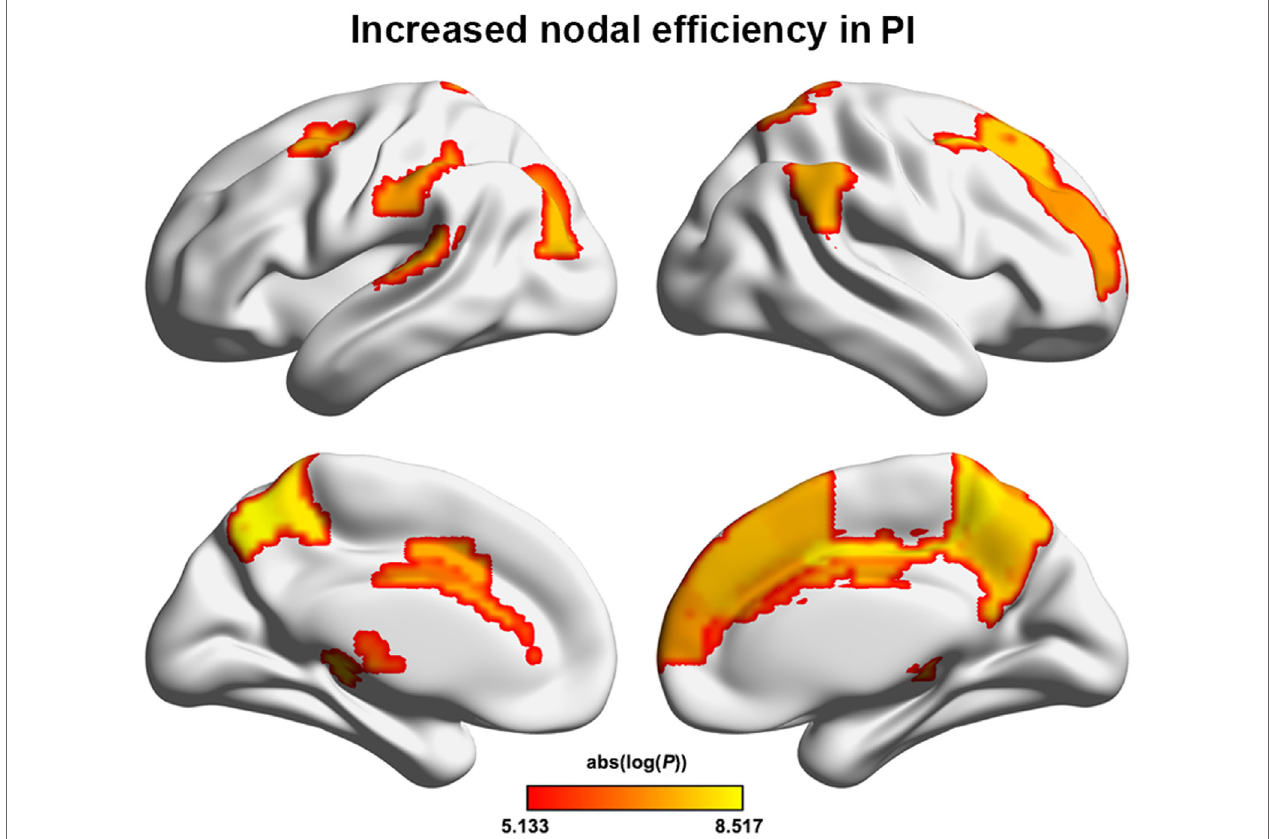
FigUre 2 | Between-group differences in regional nodal efficiency. Warm color regions show significantly increased nodal efficiency of several prefrontal and parietal regions, the superior temporal gyrus, and the thalamus in patients with PI ( P < 0.05, corrected). PI, primary